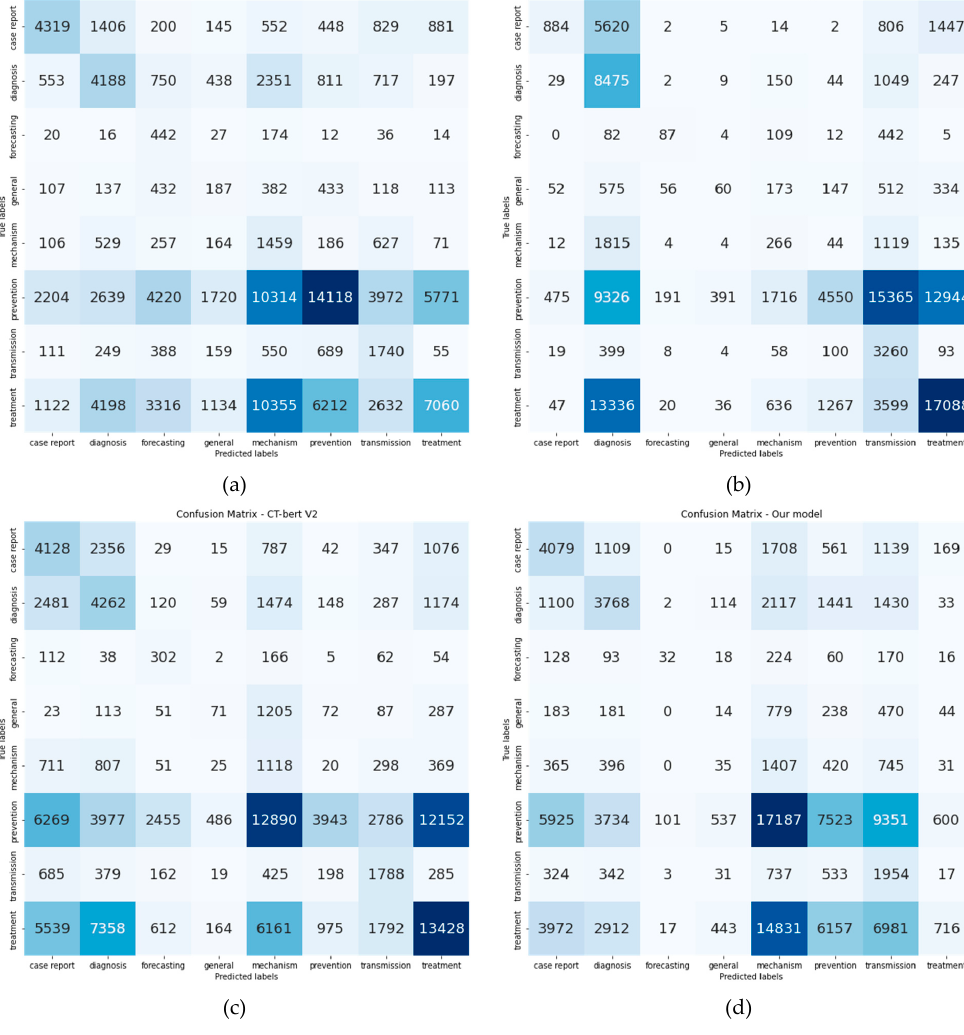
Figure 10. Confusion matrix from all models: ( a ) xlm-roberta-large, ( b ) bart-large, ( c ) CT-bert V2, ( d ) Our model .